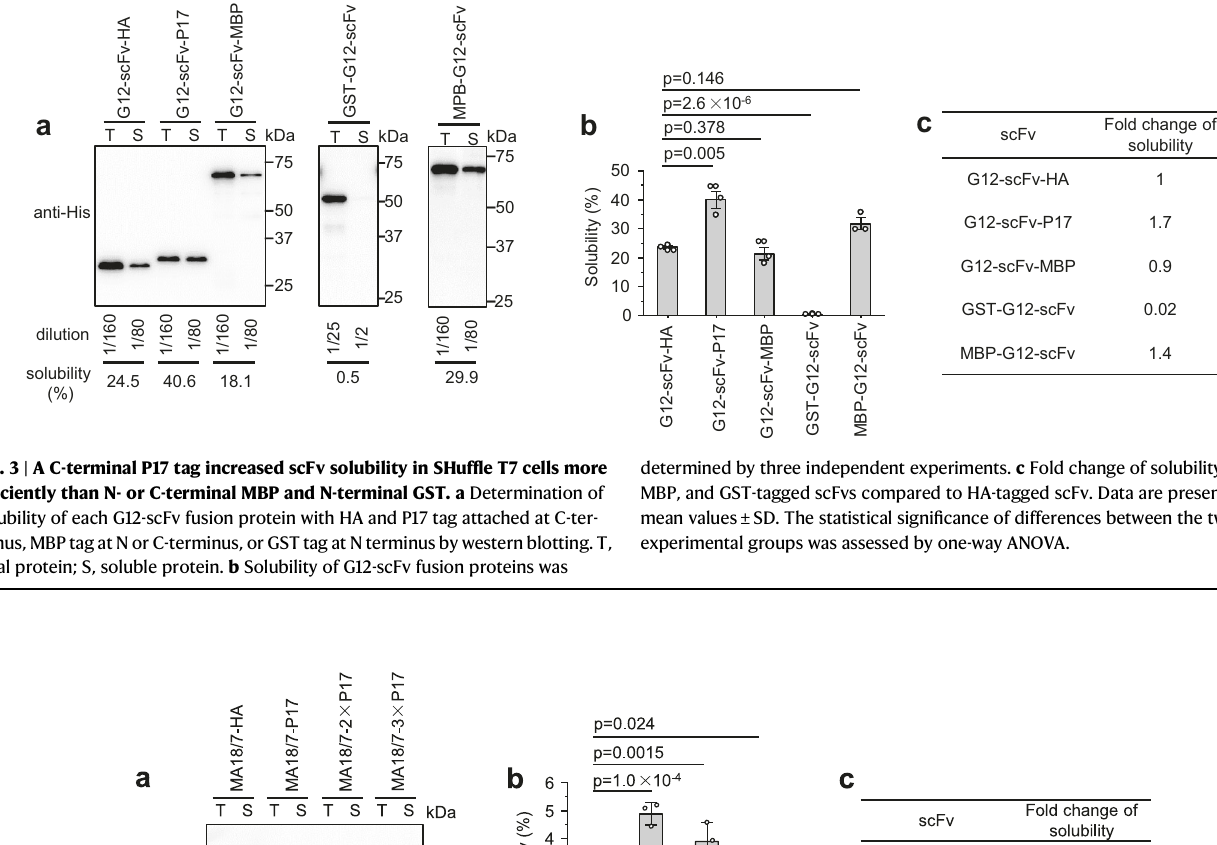
Fig. 4 | Effects of fusion of one, two, or three C-terminal P17 tag(s) on scFv ’ s solubility in SHuf fl e T7 cells. a Determination of solubility of MA18/7-scFv-HA protein and MA18/7-scFv fusion protein with one, two, and three P17 tag(s) indi- vidually attached at the C-terminus by western blotting. T total protein, S soluble protein. b Solubility of MA18/7-scFv-HA and three other MA18/7-scFv fusion